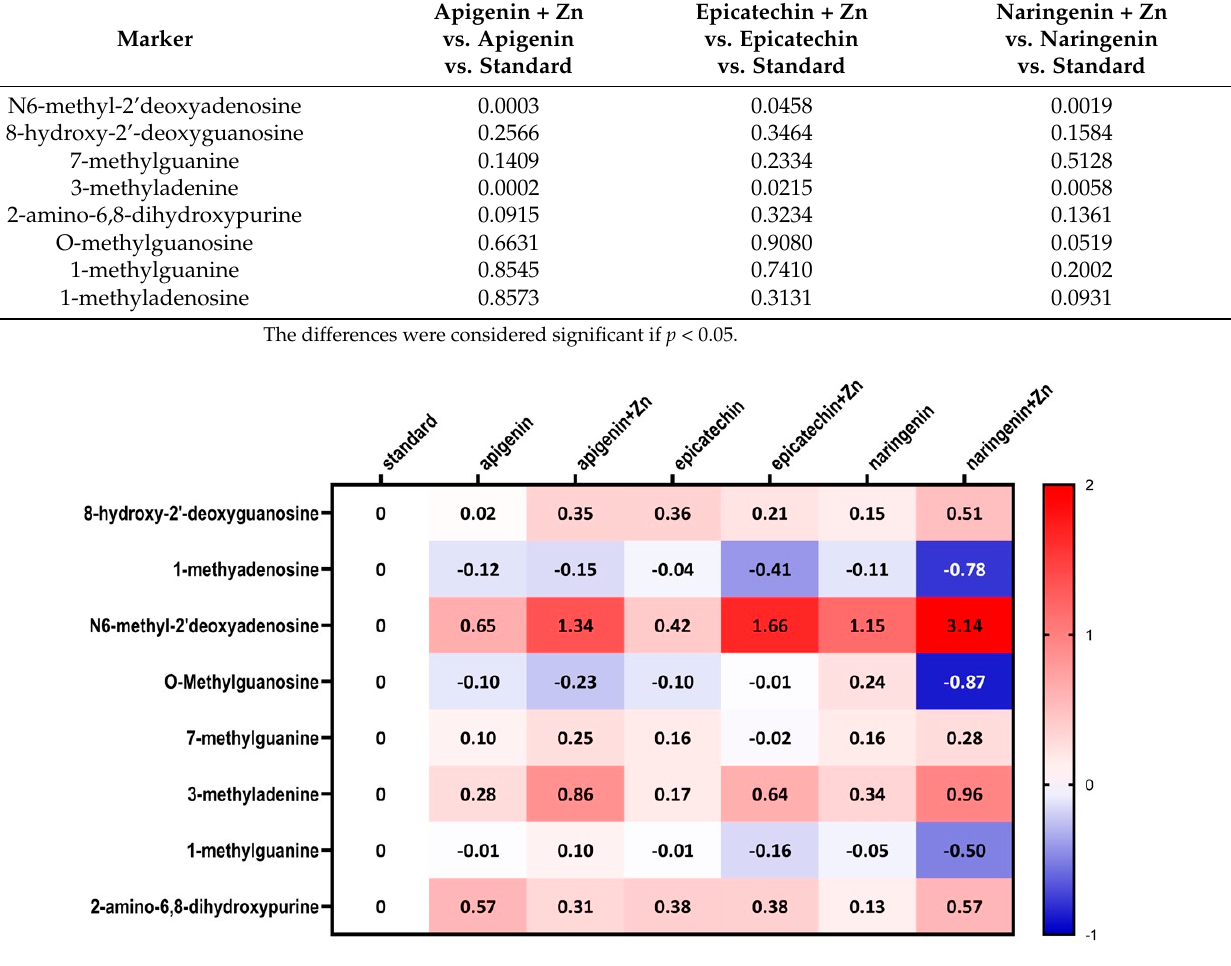
Figure 5. Heatmap of changes of the selected methyl nucleosides derivatives contents depending on the type of supplementation used compared to standard group (i.e., group 1). Table 2. The results of significance differences among means of experimental groups.